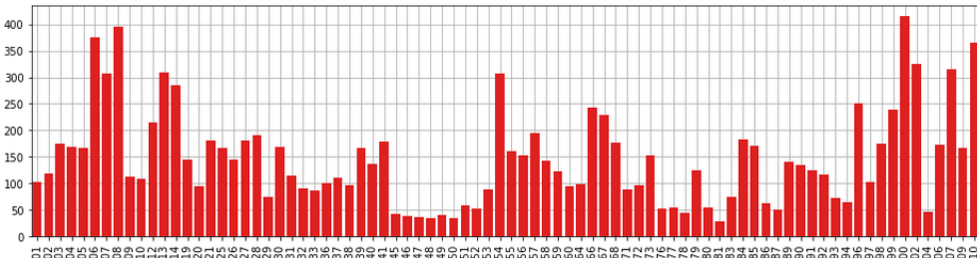
Figure 2. Average person count in each of the VisDrone 2020 CC